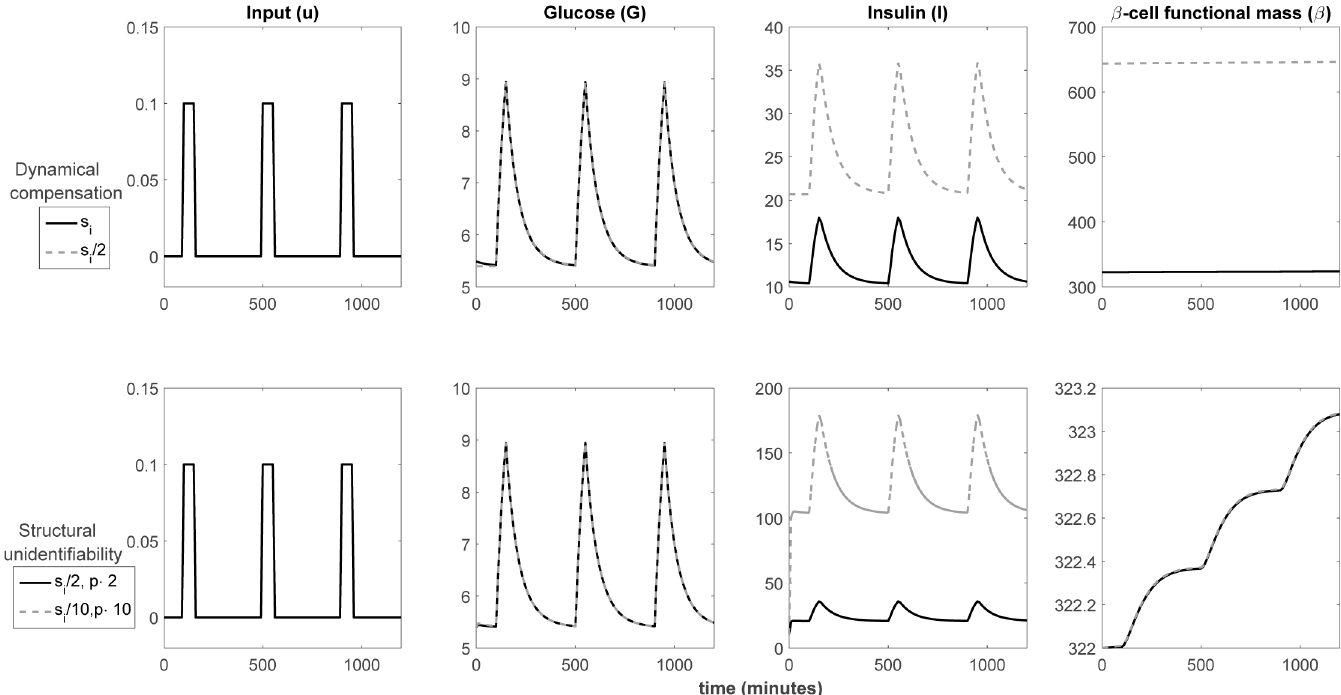
Fig 3. Dynamical compensation and structural unidentifiability in the β IG model. The first row reproducesthe last row of Fig 2 and illustrates the phenomenon of dynamical compensation: after the system has adaptedto the new value of s i , the time-evolution of the glucoseconcentration (G) for the new value of ( s i /2) is the same as it was with the old value before adaptation( s i ). The second row illustrates the phenomenonof structural unidentifiability: without the need for any adaptation, the time-evolution of the glucoseconcentration (G) is the same for any value of the parameter s i , as long as any deviationsfrom the originalvalue are compensatedby changesin the parameter p . Note that, since the upper and lower plots of G are identical, if glucoseis the only measuredquantity both phenomena cannot be distinguished. However,the behaviourof the other state variables(I, β ) can be very different, as can be noticedfrom the third and fourth